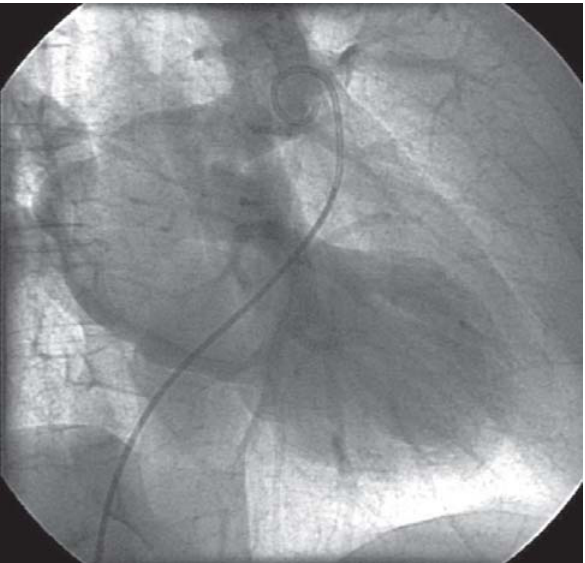
Fig. 1 - Cateterismo: mixoma atrial gigante em átrio esquerdo